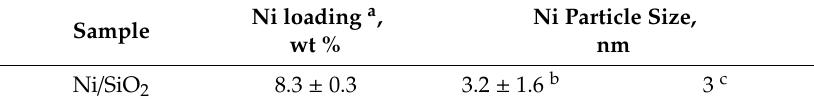
Table 2. Composition and particle size of the catalyst.